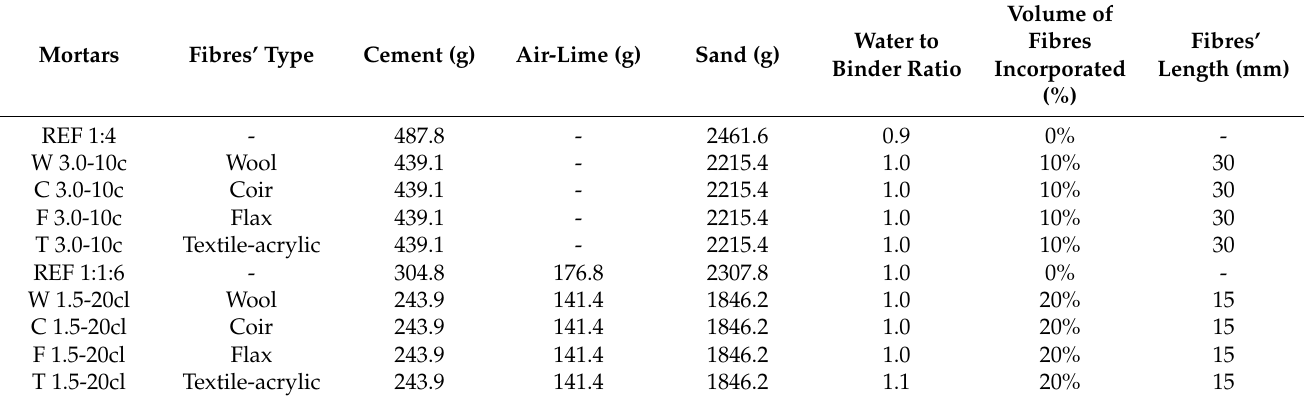
Table 2. Composition of the mortar’s